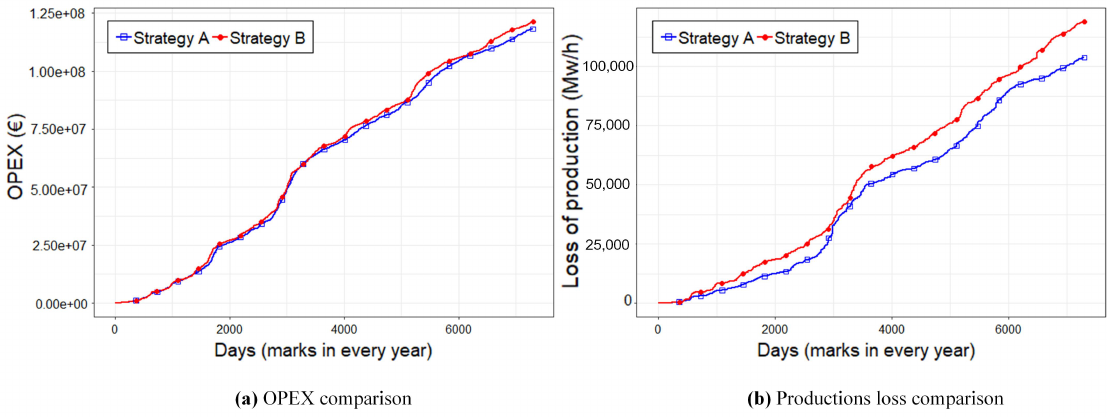
Figure 6. Performance comparison of costs ( a ) and production loss ( b ) of strategies A and